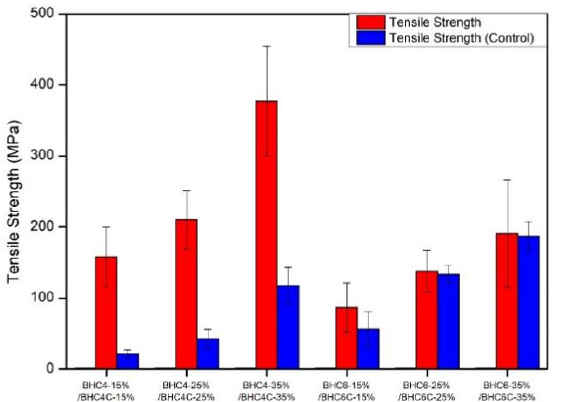
Figure 6. Tensile strength of samples from the experimental group and the control group. The experimental group refers to the formulation in Table 1; the control group refers to the formulation in Table